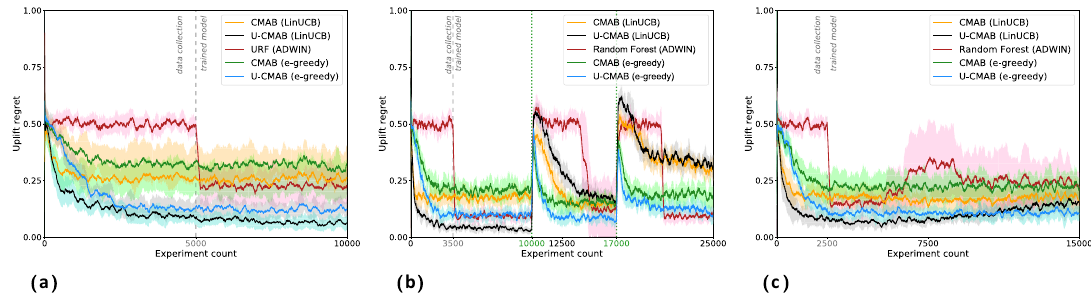
Figure 6: Average performance in simulated environments . We compare our U - CMAB to a CMAB and URF, in k 10 = , distinct random environments. The grey dashed line indicates the end of the fi rst data gathering period for the URF, yielding a regret of 0.5 as treatments are applied randomly. Dotted lines in ( b ) indicate a sudden drift. From these experiments, it is clear that across environments, the U - CMAB is performing best. ( a ) No drift. ( b ) No drift, ( c ) No